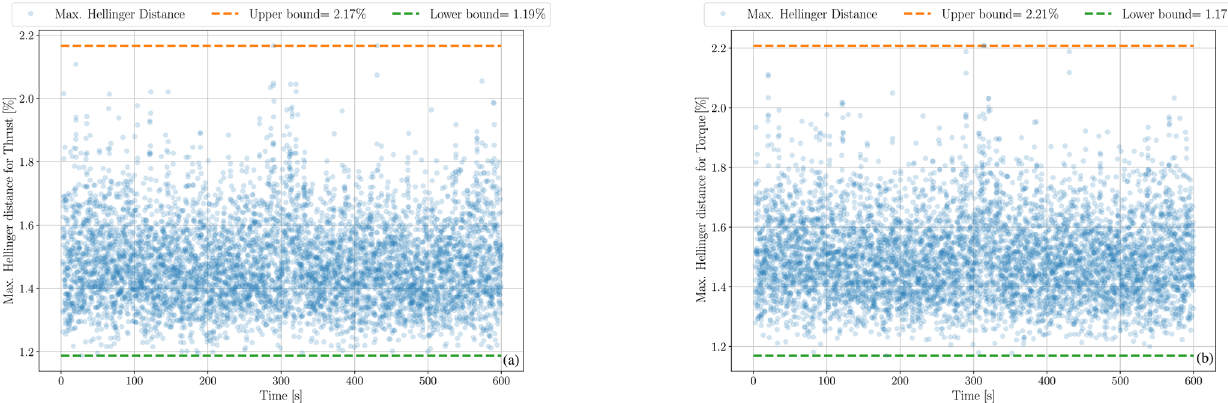
Figure 3. Maximum Hellinger distance for thrust and torque at each time step. The upper and lower bounds for the extreme of the Hellinger distance are